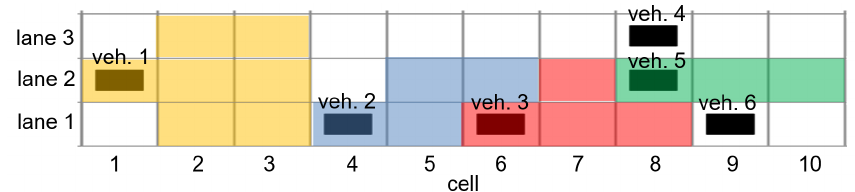
Figure 2. Possible vehicles positions determined for multilane